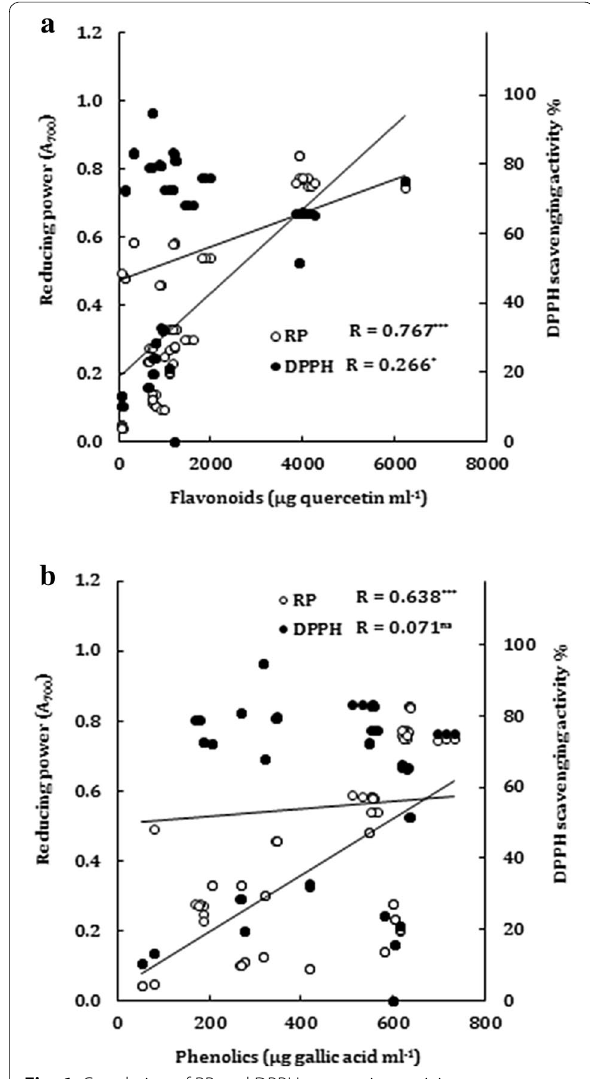
Fig. 6 Correlation of RP and DPPH scavenging activity versus flavonoids ( a ) and phenolics ( b ) of an SSFS employing two basidiomycete fungi: P. columbinus and P. floridanus and two ascomycetes: A. fumigatus and P. variotii on peels of banana, pomegranate and orange, empty pea pods and rice straw. The values of R with (*), (***) and (ns) refer to significant, very highly significant and non‑significant correlation,